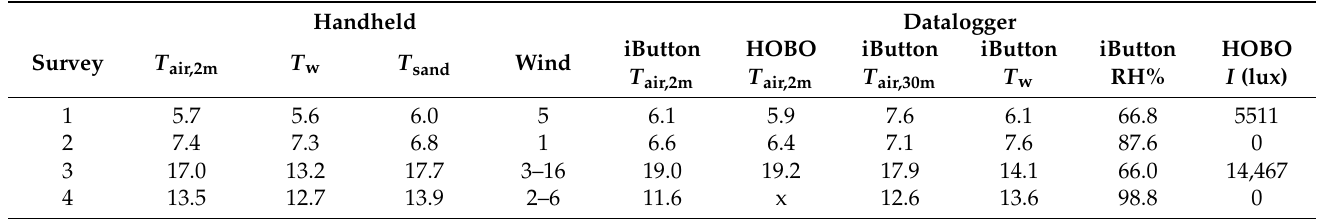
Table 4. Environmental conditions, measured during the UAV survey using handheld probes and dataloggers, with temperatures in ◦ C and wind speed in km/hr.